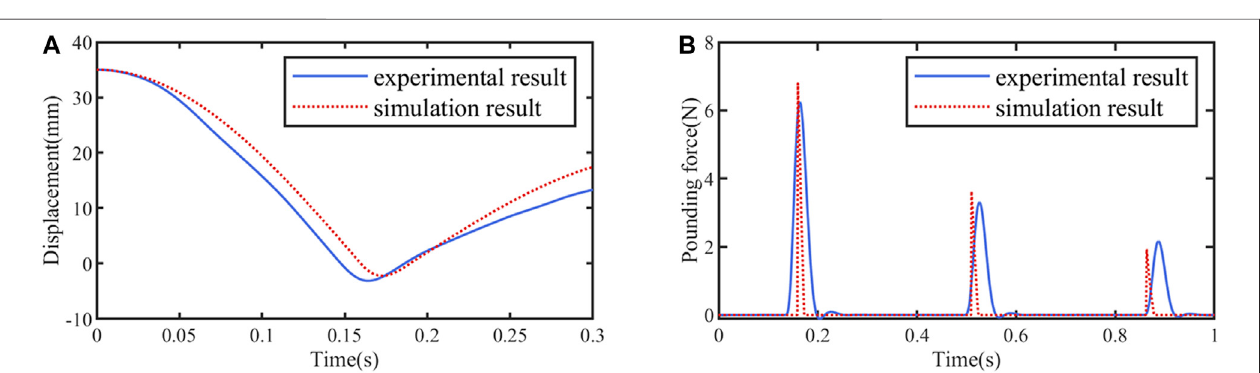
FIGURE 12 | The results of the impact test: (A) Time history records of mass displacement; (B) Time history records of impact